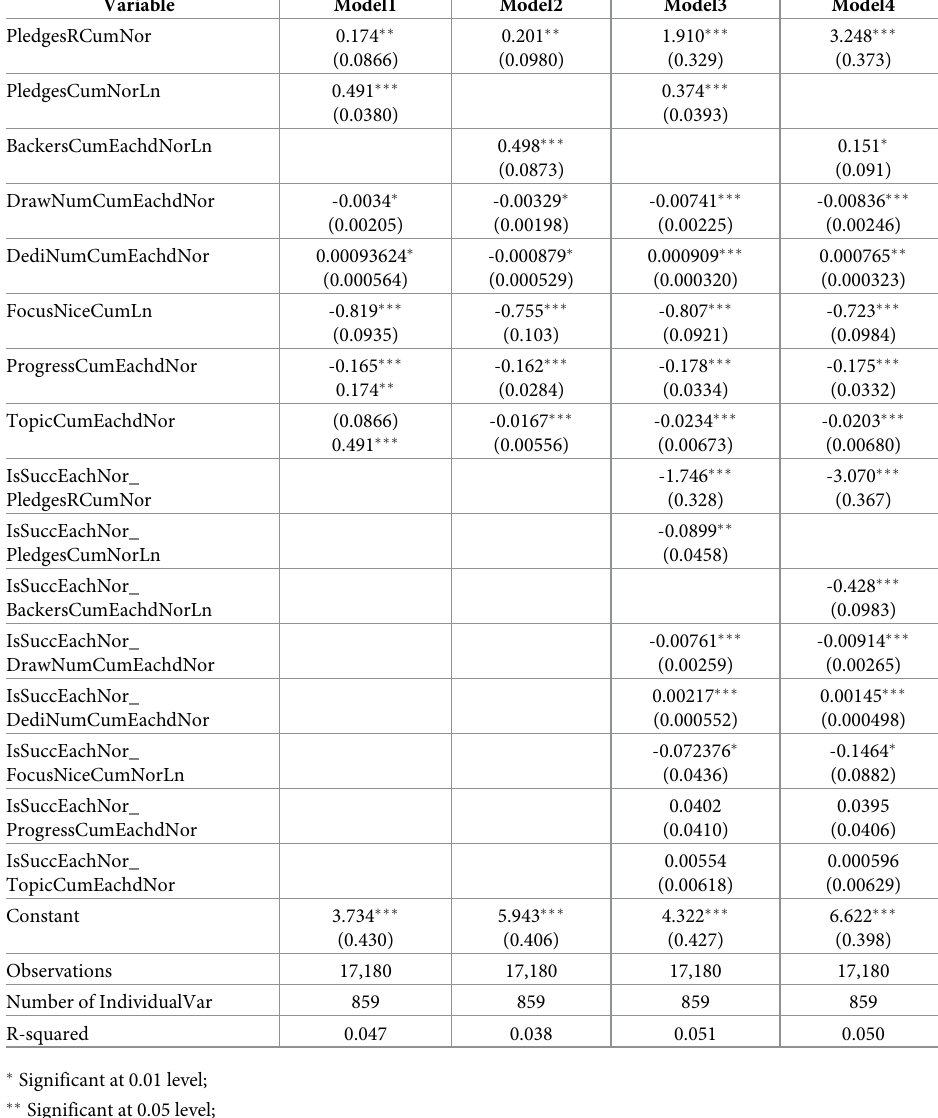
Table 6. Fixed effect on the explicit signals of projects using PledgesIncrNorYLn as dependent